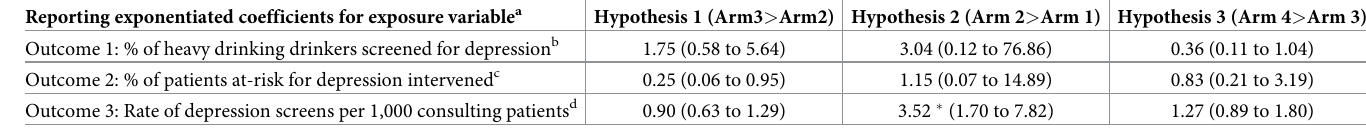
Table 3. Results of regression analyses for evaluating the three hypotheses for three